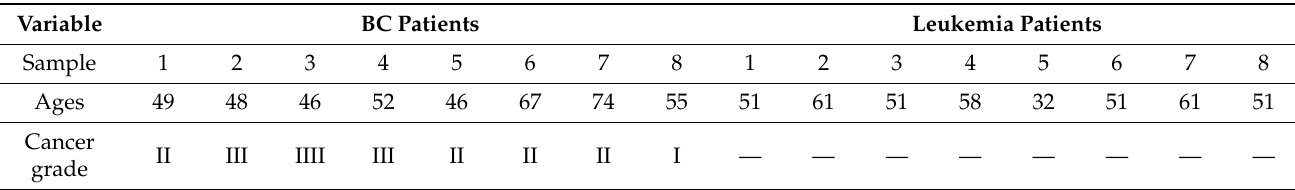
Table 5. Breast cancer (BC) and leukemia patients’ ages and their cancer